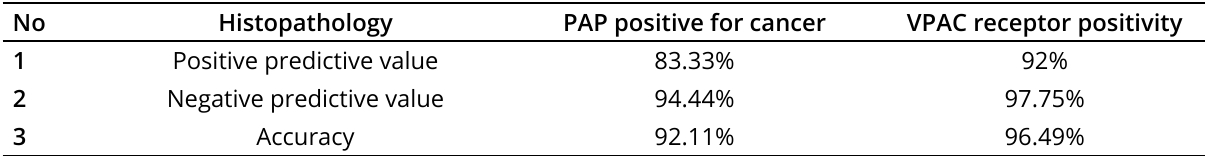
Table 4. Association between VPAC receptor and PAP